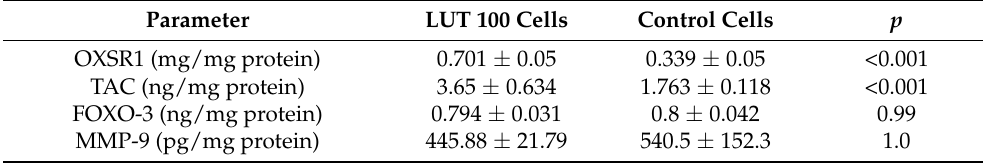
Table 1. Mean values of OXSR1, TAC, FOXO-3 and MMP-9 in lutein (100 mg)—Lut100-treated oral cancer cells, and control cells (Lut 100—oral cancer squamous cells incubated with lutein (100 mg); CR—control oral cancer squamous